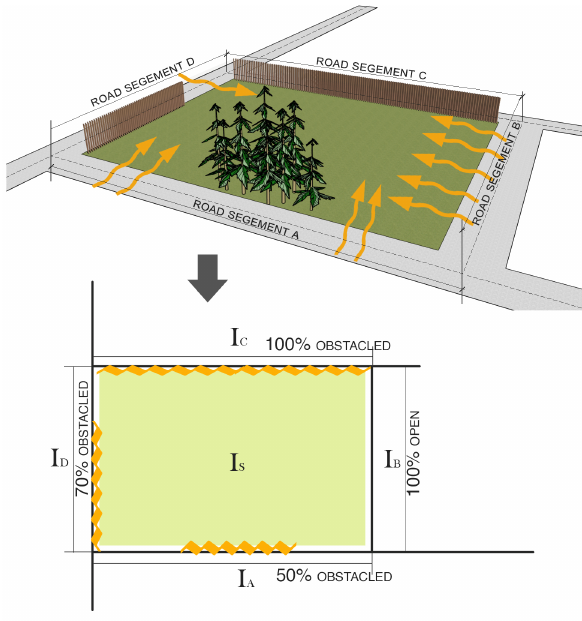
Figure 4. Schematic diagram of green space integration value